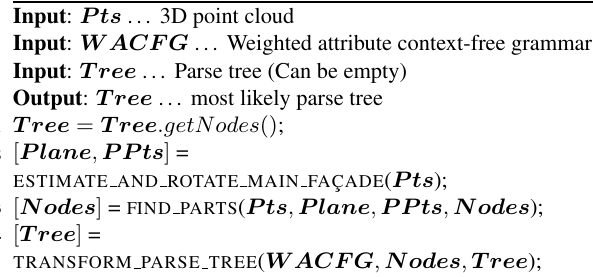
Algorithm 1: PARSE FAC ¸ ADE – Weighted attribute grammar based incremental parsing of a 3D point cloud stream